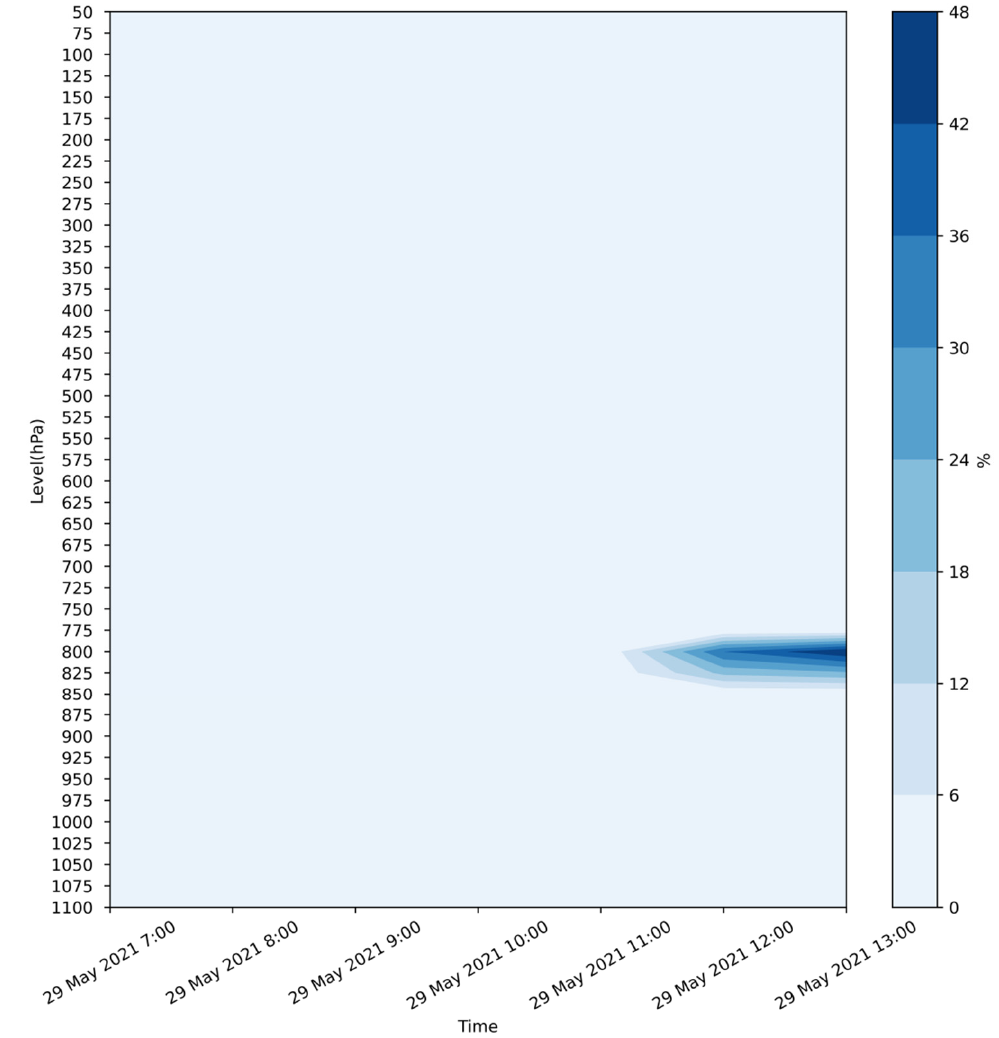
Figure 9. Cloud cover time series of 3Dcloud gridded fusion product at AWS M0307.